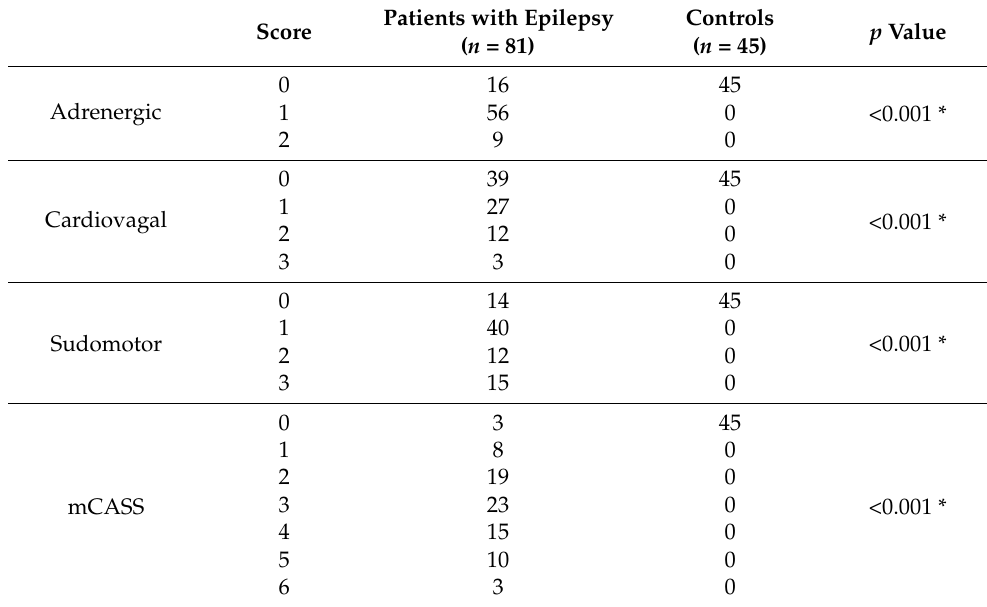
Controls p Value ( n = 45)